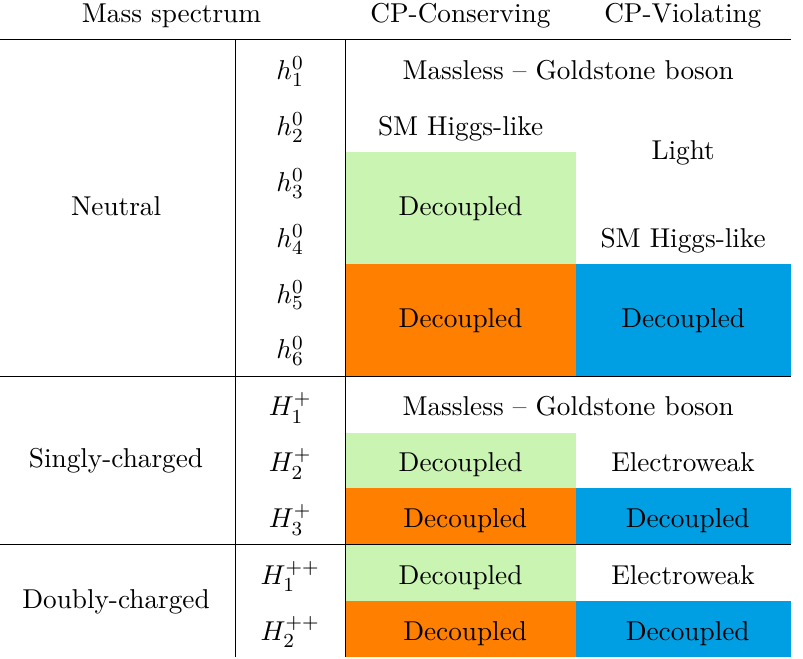
Table 1 . Main features of the neutral and charged-scalar mass spectrum in the 2STM for the CP-conserving and CP-violating vacuum cases. Scalars marked with the same colours have masses of similar magnitude. Here,“Decoupled” is applicable to the states for which the mass can be arbitrary large, while “Electroweak” is used for those whose mass is, typically, around the electroweak